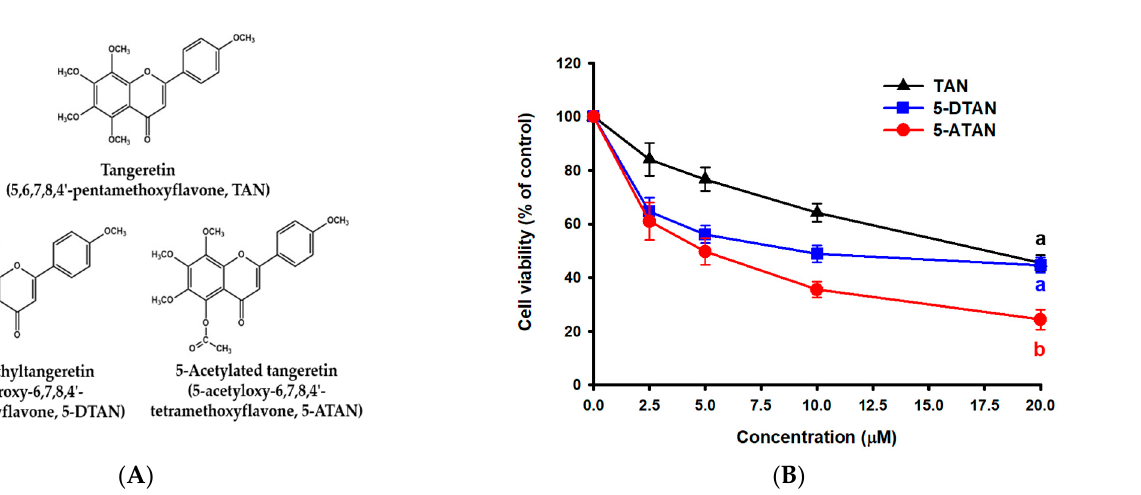
Figure 1. Effects of tangeretin (TAN), 5-demethyltangeretin (5-DTAN), and 5-acetylated tangeretin (5-ATAN) on cell viability in PC-3 cells. ( A ) Chemical structures of TAN, 5-DTAN, and 5-ATAN. ( B ) Cells were treated with various concentrations of TAN, 5-DTAN, or 5-ATAN for 48 h. Data are expressed as means ± SD ( n = 3). The values with different letters are significantly different among treatments at the highest concentration ( p < 0.05).